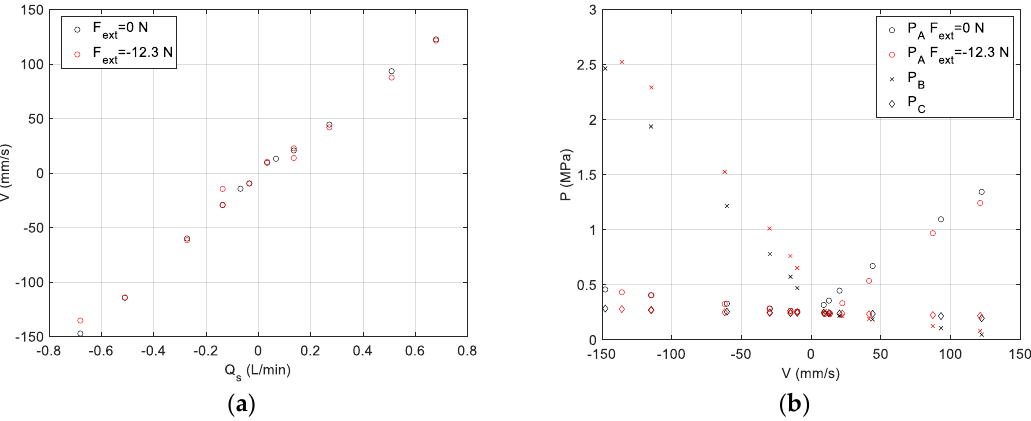
Figure 7. Experimental data for system with Valve B (entirely 3D printed) for two loading conditions: ( a ) actuator velocity with respect to commanded pump speed; ( b ) pressures with respect to actuator velocity. Table 1. Basic model parameters.